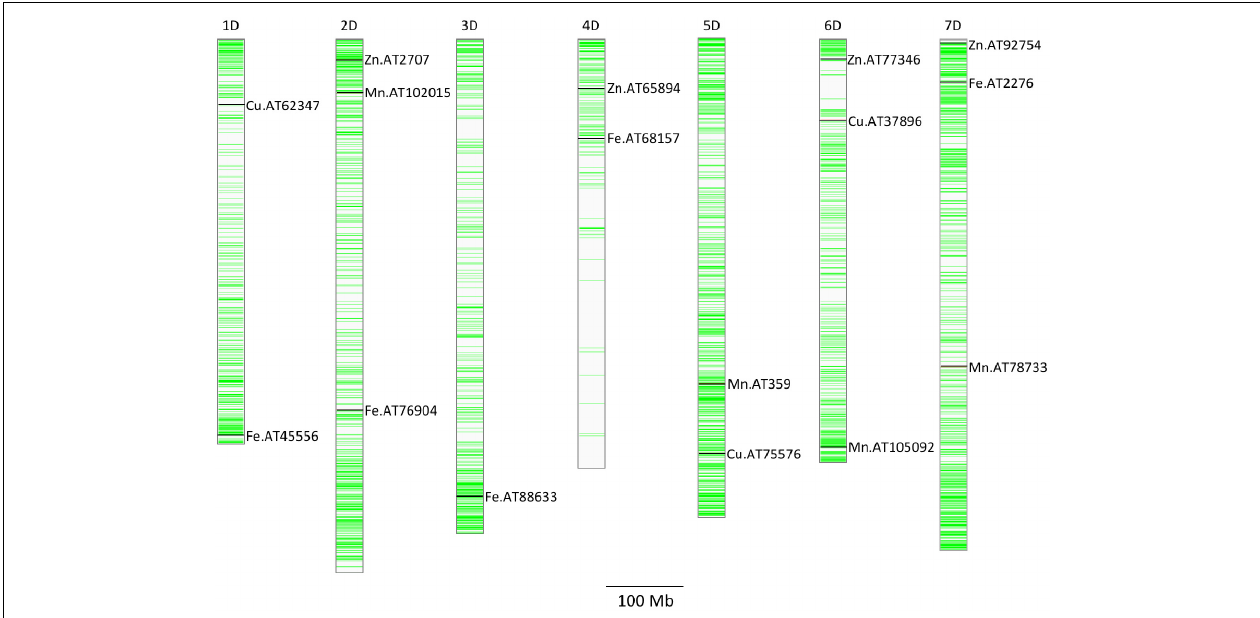
FIGURE 5 | Distribution of GBS SNP markers across the seven Ae. tauschii chromosome arms. The horizontal line color bars indicate the chromosomal position of the markers. The associated markers for micronutrients concentration reported in this study are indicated by black bars. Associated SNPs are indicated by name of the micronutrient followed by AT indicating Ae. tauschii and SNP